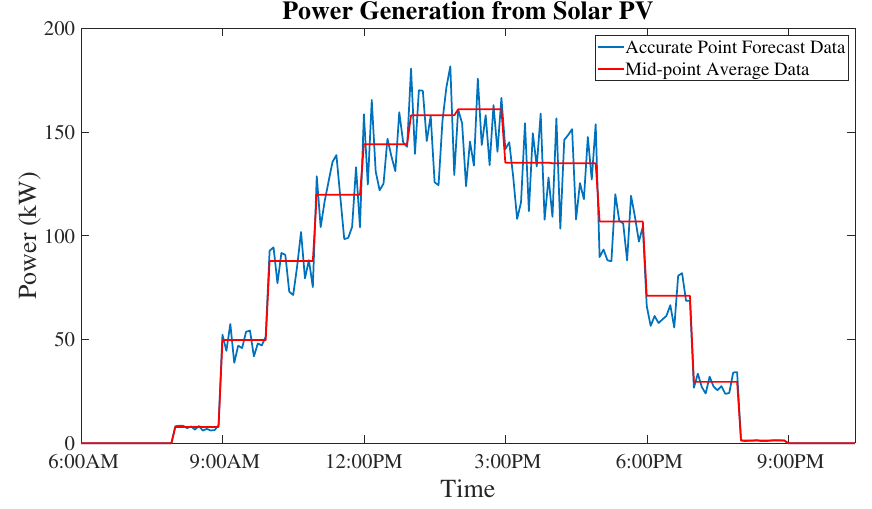
Figure 9. Mid-point average photovoltaic power generation.